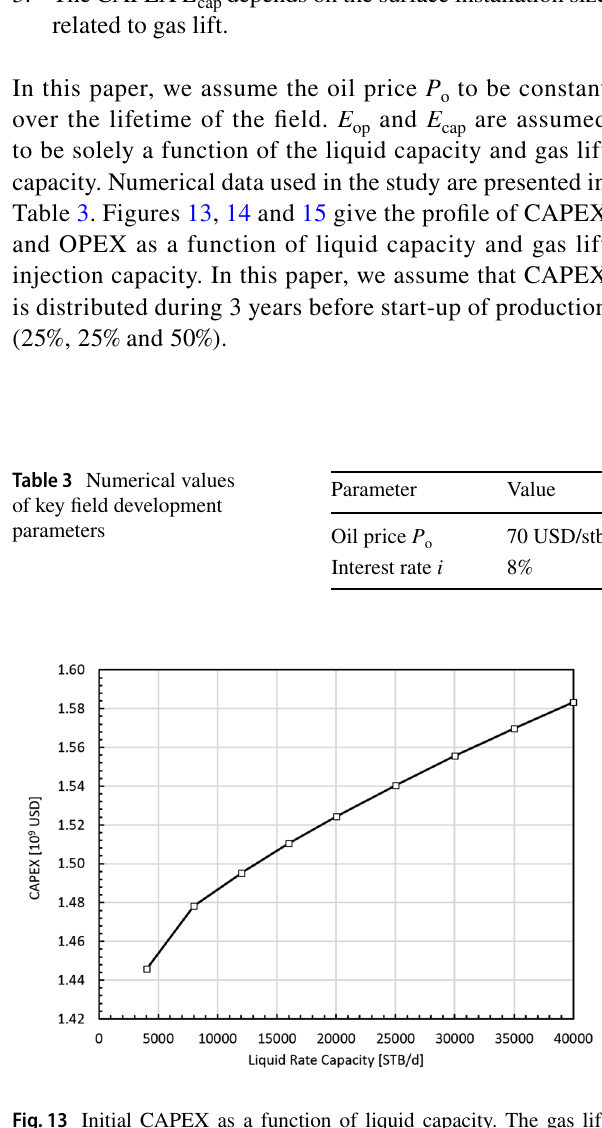
Fig. 12 Execution time of the solution for a single time step